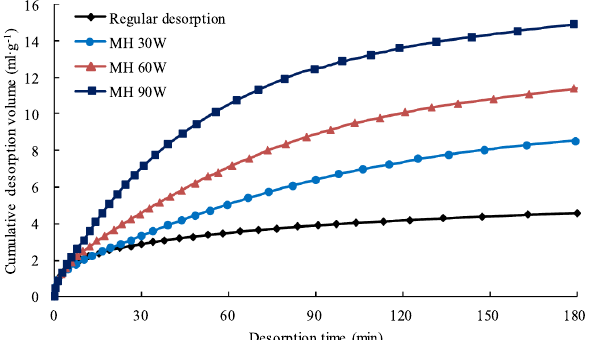
Figure 5. Cumulative desorbed volume of methane vs. time curves for MH and room temperature coal desorption tests.